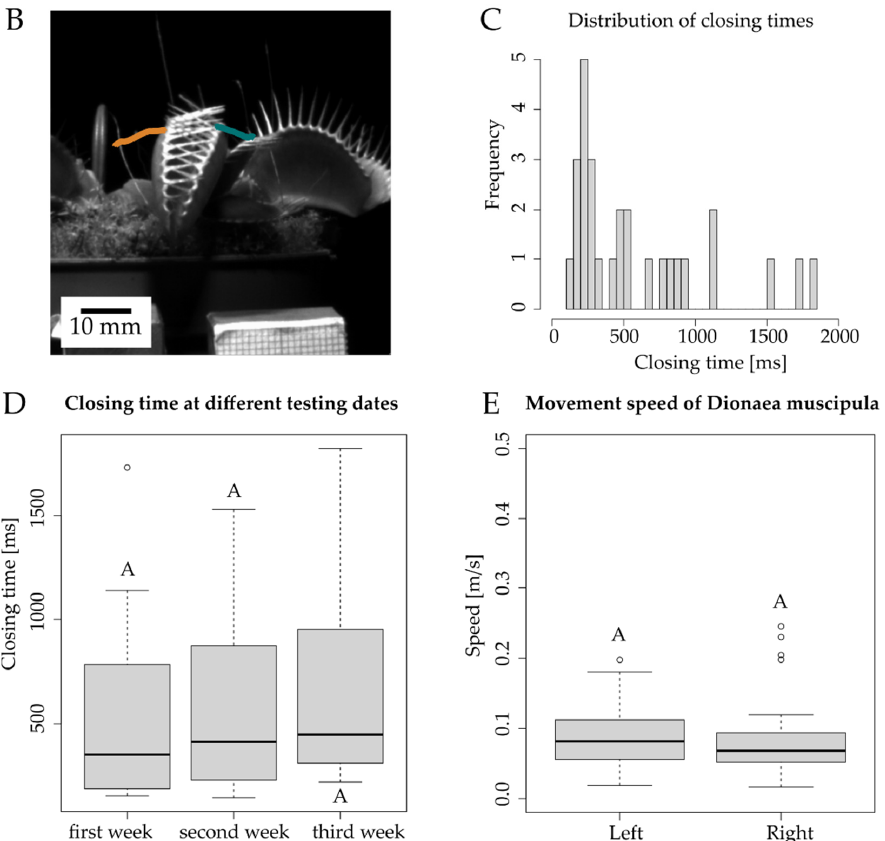
Figure 3. High-speed recording of the Venus flytrap from two angles gave a good impression of the overall movement ( A ). The path of motion was tracked at the base of the marginal teeth (orange and green lines) ( B ), and the movement speed was measured for these particular trajectories. Average closing time ranged from 550 to 680 ms for the three weeks of testing ( C ), whereas over half of the closing events needed less than 500 ms. The box plots represent 12, 8, and 8 measurements for week one, two, and three, respectively ( D ). Lobe tips reached velocities of between 0.016 and 0.24 m/s during closing. Each plot includes 28 measurements ( E